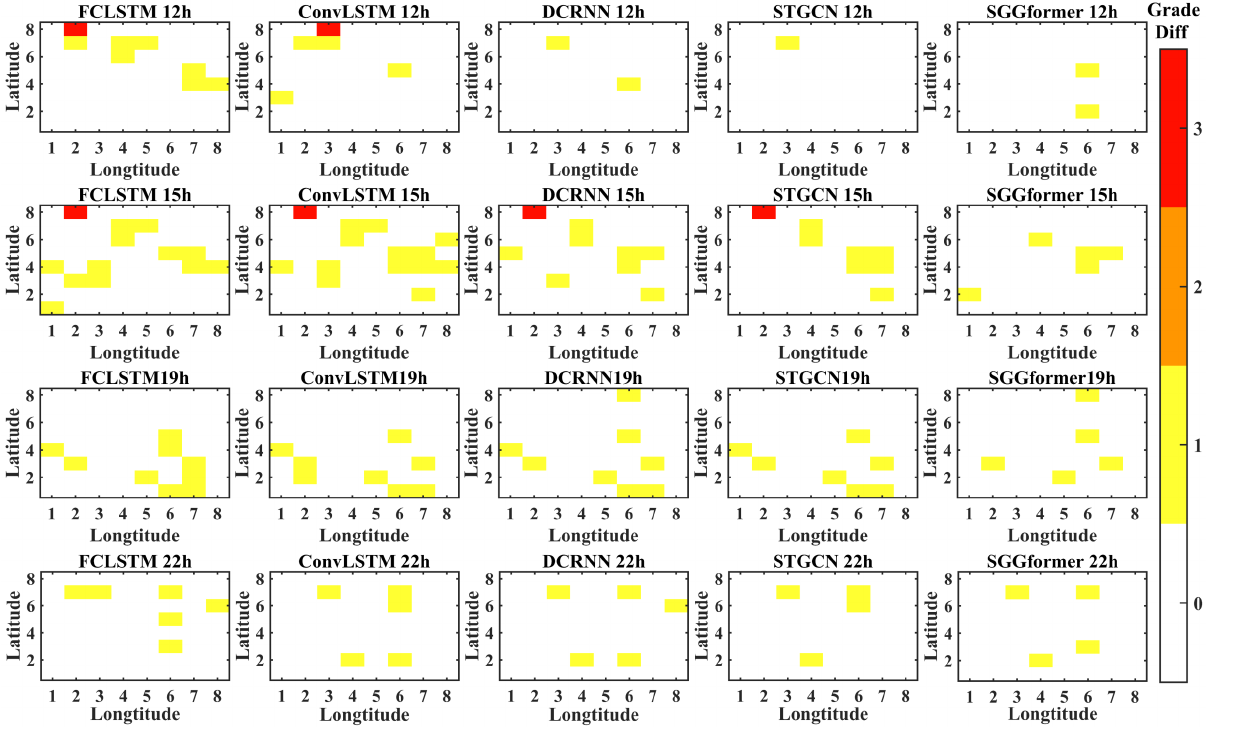
Figure 13. The grade difference under prediction length 6